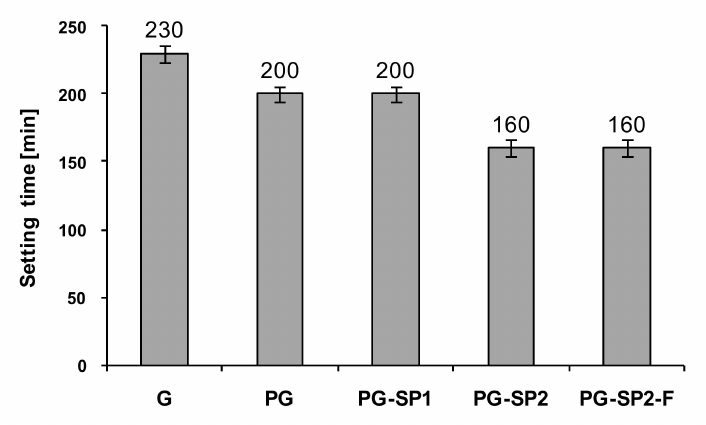
Figure 1. The initial setting time of modified gypsum plasters with standard